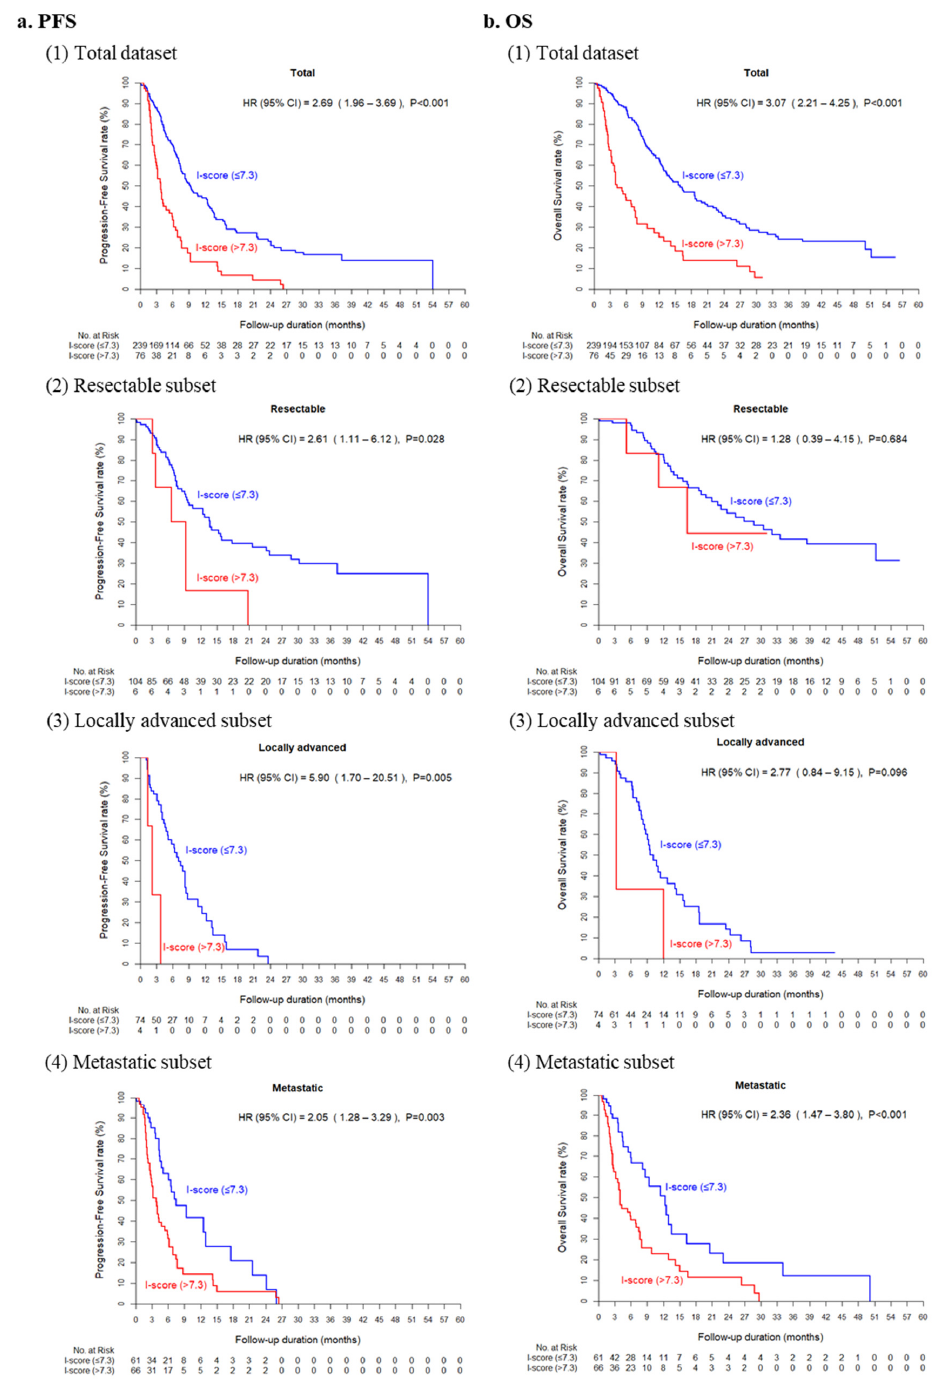
Figure 2. Prognostic impact of circulating tumor DNA I-score. Kaplan–Meier curves for progression-free survival ( a ) and overall survival ( b ) curves according to I-score in total dataset ( 1 ) and resectable ( 2 ), locally advanced ( 3 ), and metastatic ( 4 ) subsets.